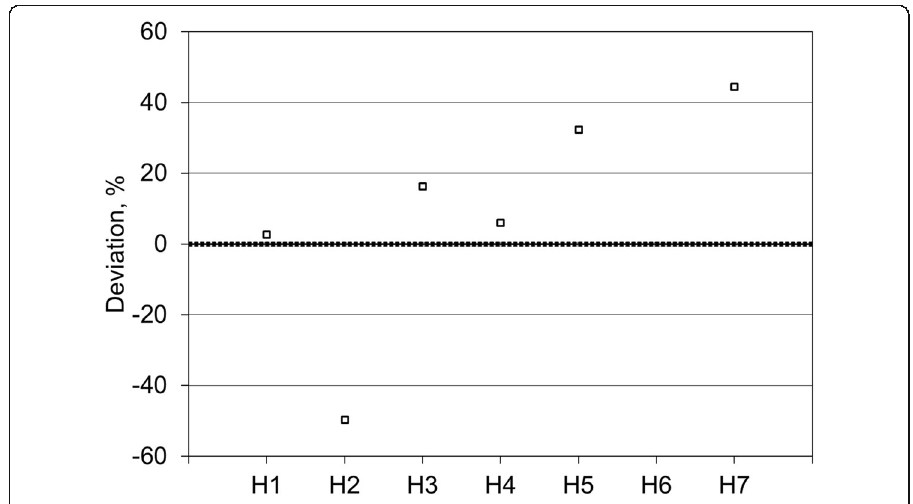
Fig. 5 Participants reported volumes for the entire comparison source